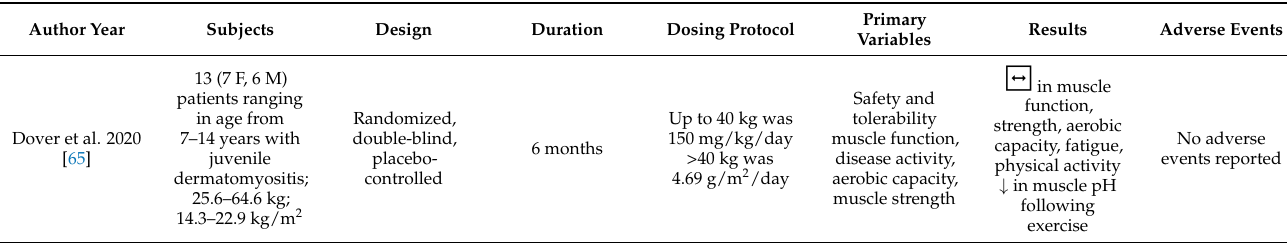
Table 2. Efficacy of creatine in clinical settings.